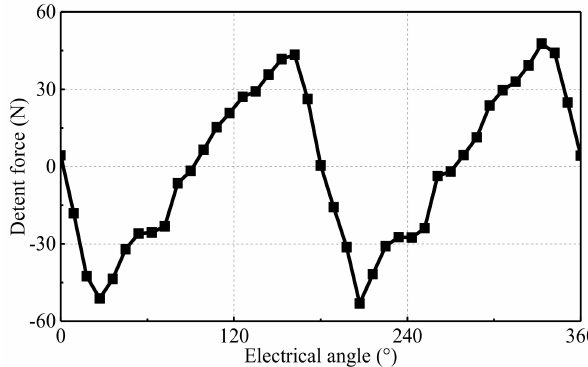
Figure 3. Detent force of the 120 ◦ -TWDSPMLSM.